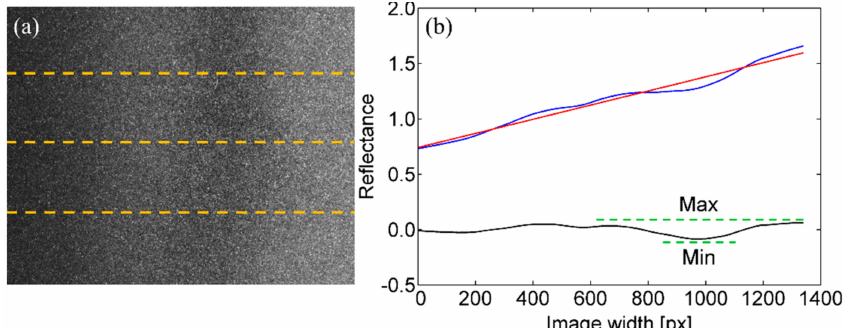
Figure 3. ( a ) Image of a sample with striping, and ( b ) a plot with the averaged and smoothed image profile (blue line), the linearly fitted curve (red line) and the subtraction profile D St (black